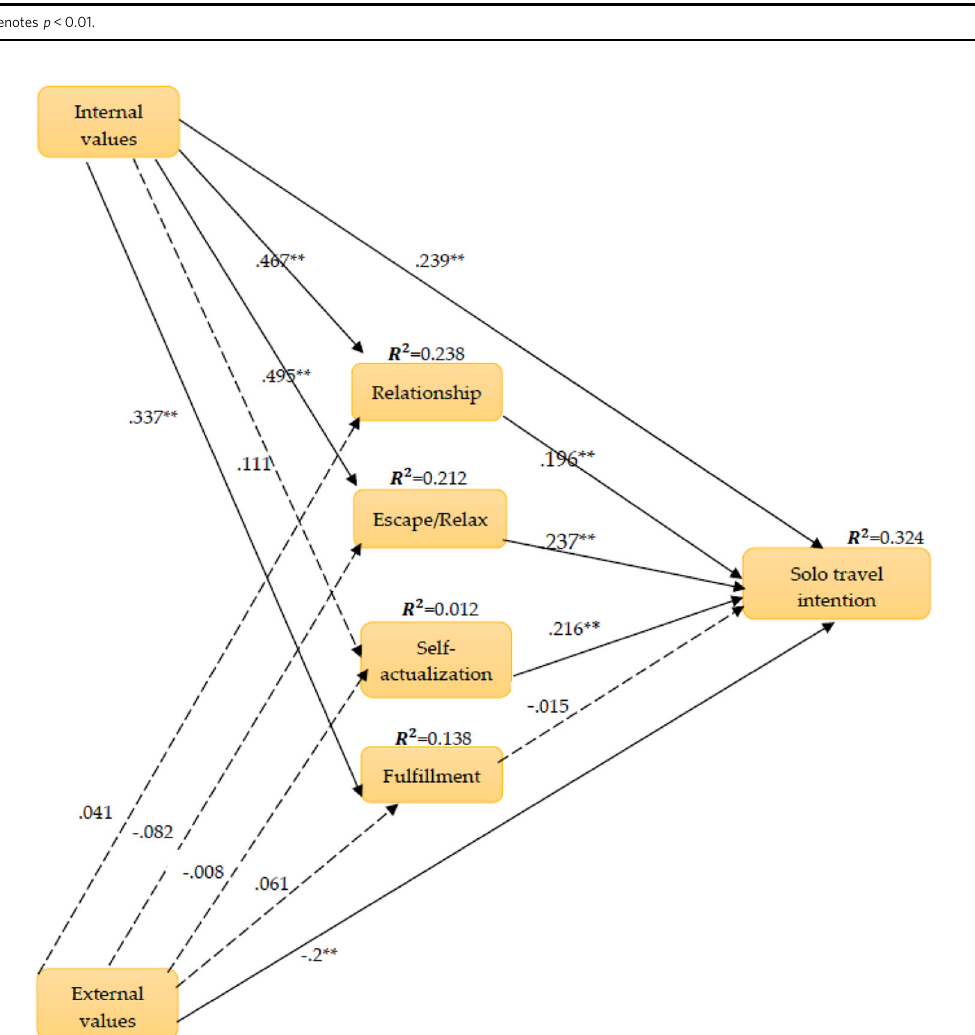
Fig. 2 Path diagram of the structural model (**denotes p < 0.01). Internal values have a signi fi cant relationship with travel motivation and solo travel intention. Subsequently, travel motivation had a partially supported effect on solo travel